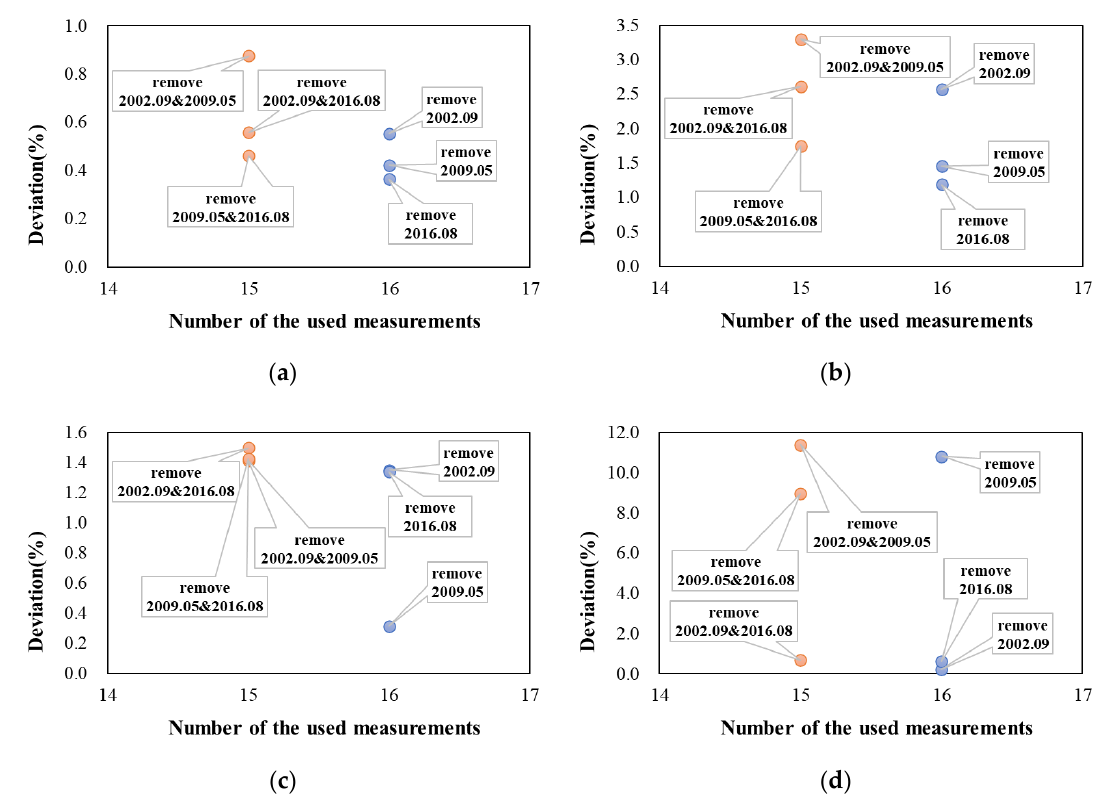
Figure 9. The deviations of eigenfunctions induced by different numbers of the bathymetric measurements, comparing with the results of the total 17 bathymetric measurements: ( a ) the deviation of EOF 1; ( b ) the deviation of EOF 2; ( c ) the deviation of EOF 3; and ( d ) the deviation of EOF 4.